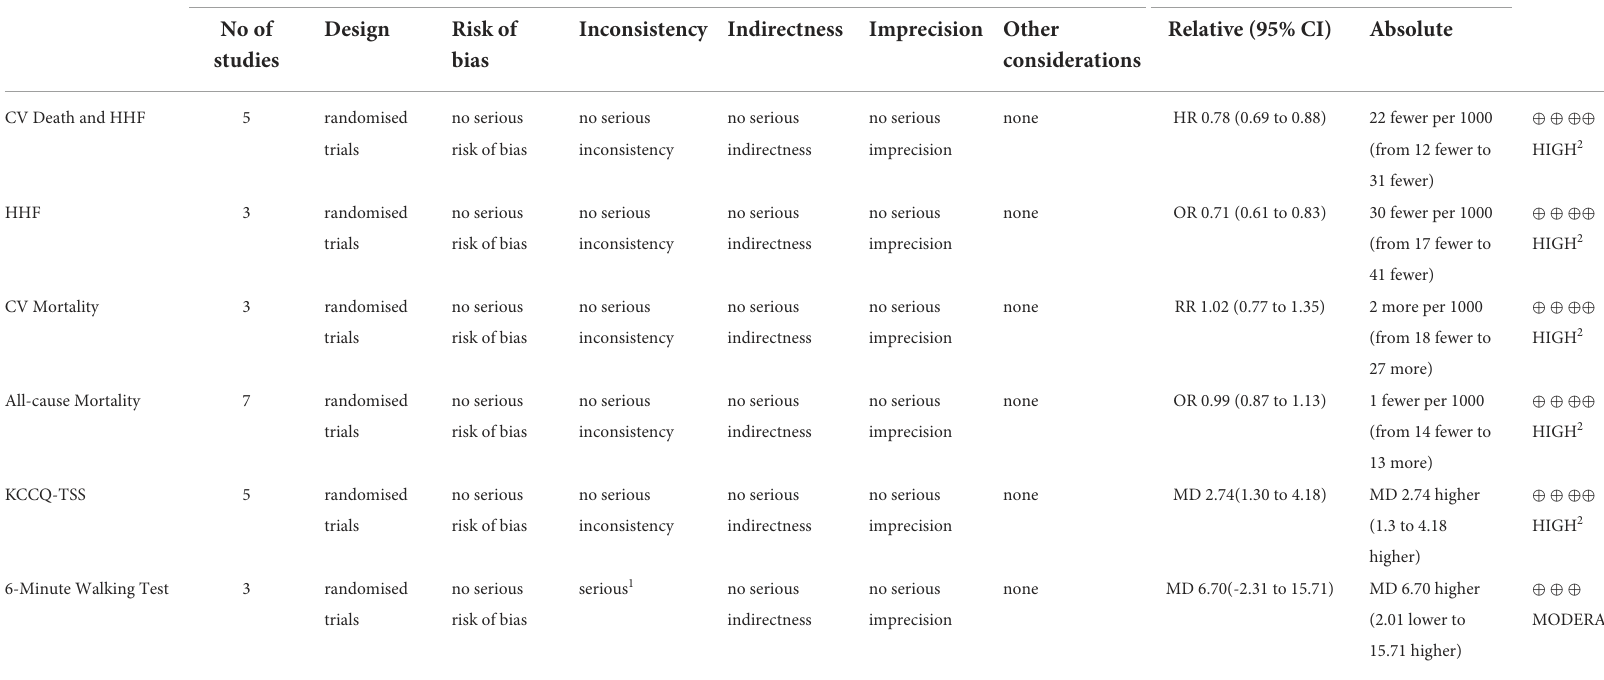
TABLE 2 Summary of